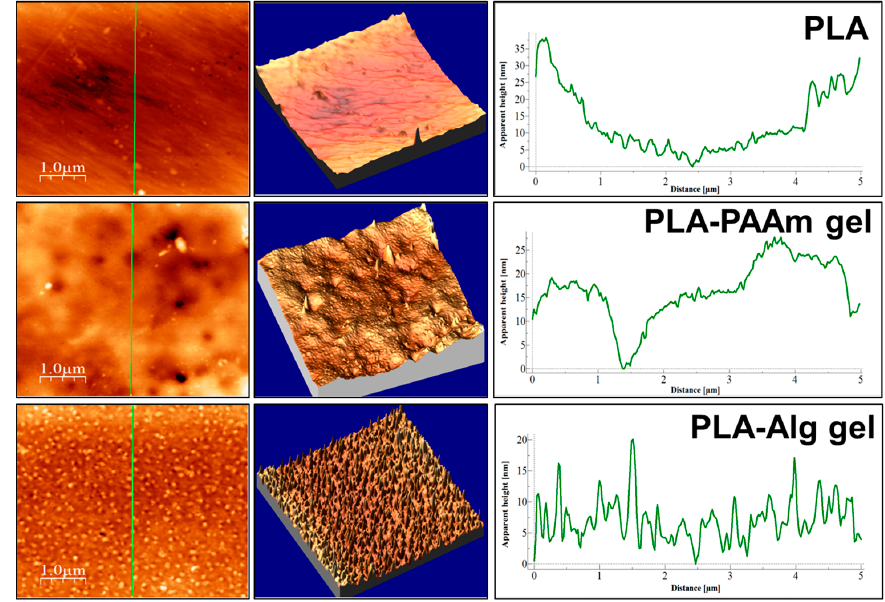
Figure 9. AFM microimages (image size 5 × 5 µm) and surface profiles of the initial and modified gels.